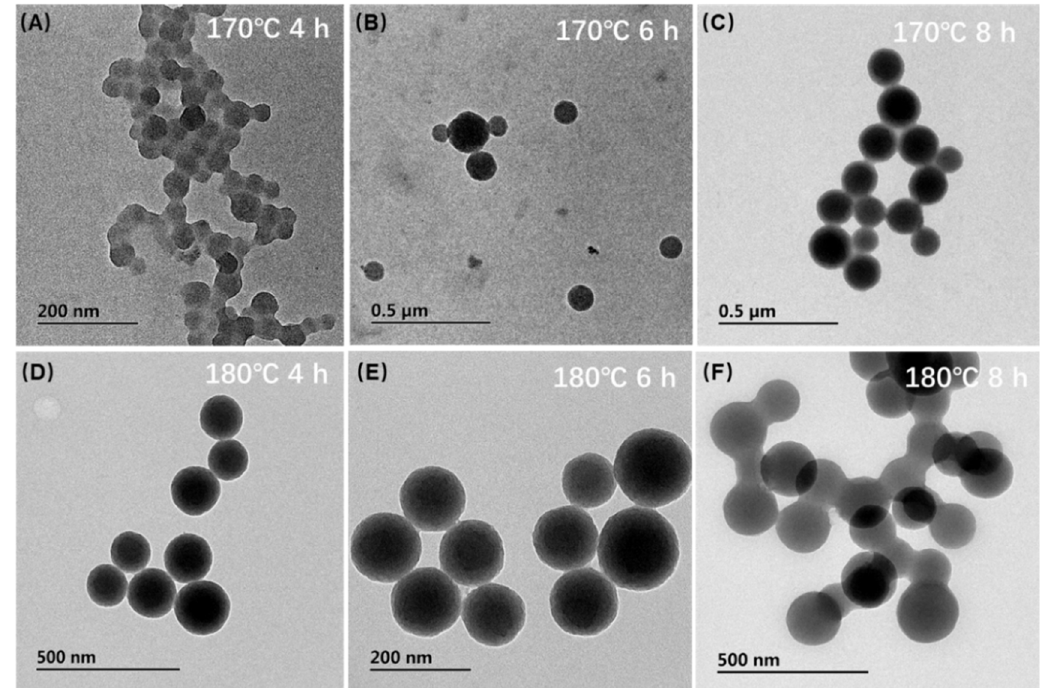
Figure 2. Optimization of CNs synthesis. TEM characterization of the synthesized CNs by hydrothermal method under different temperatures with various time; ( A ) 170 °C with 4 h, ( B ) 170 °C with 6 h, ( C ) 170 °C with 8 h, ( D ) 180 °C with 4 h, ( E ) 180 °C with 6 h, and ( F ) 180 °C with 8 h.